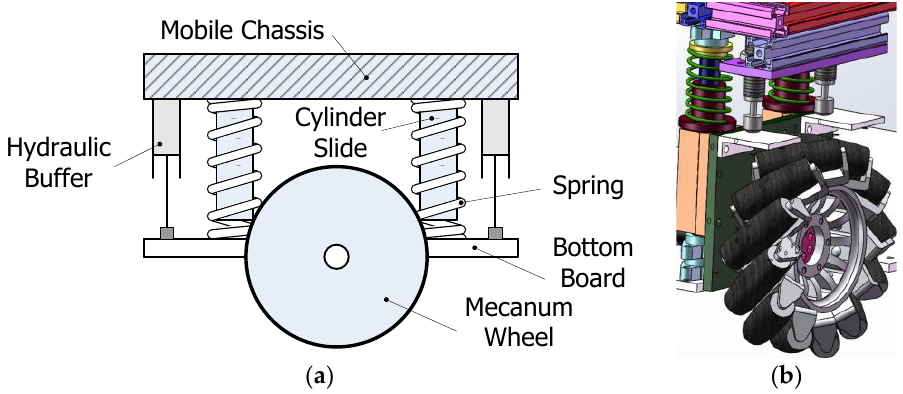
Figure 2. Modular wheel structure with suspension. ( a ) The components of the modular wheel; ( b ) 3D model of the modular wheel.